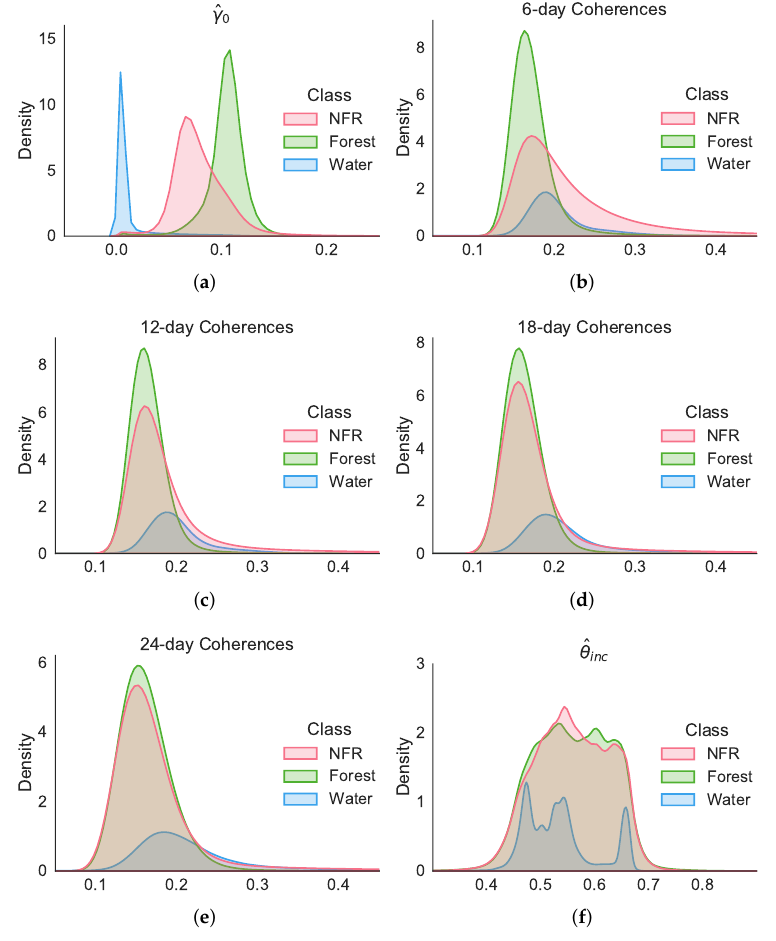
Figure 11. Normalized histograms of ( a ) the SAR backscatter, ( b – e ) the interferometric coherence at different temporal baselines, and ( f ) the local incidence